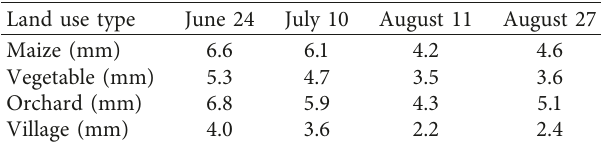
Table 6: Daily ETestimates derived by the Gaussian fitting method of the four different land use types on June 24, July 10, and August 11 and 27,